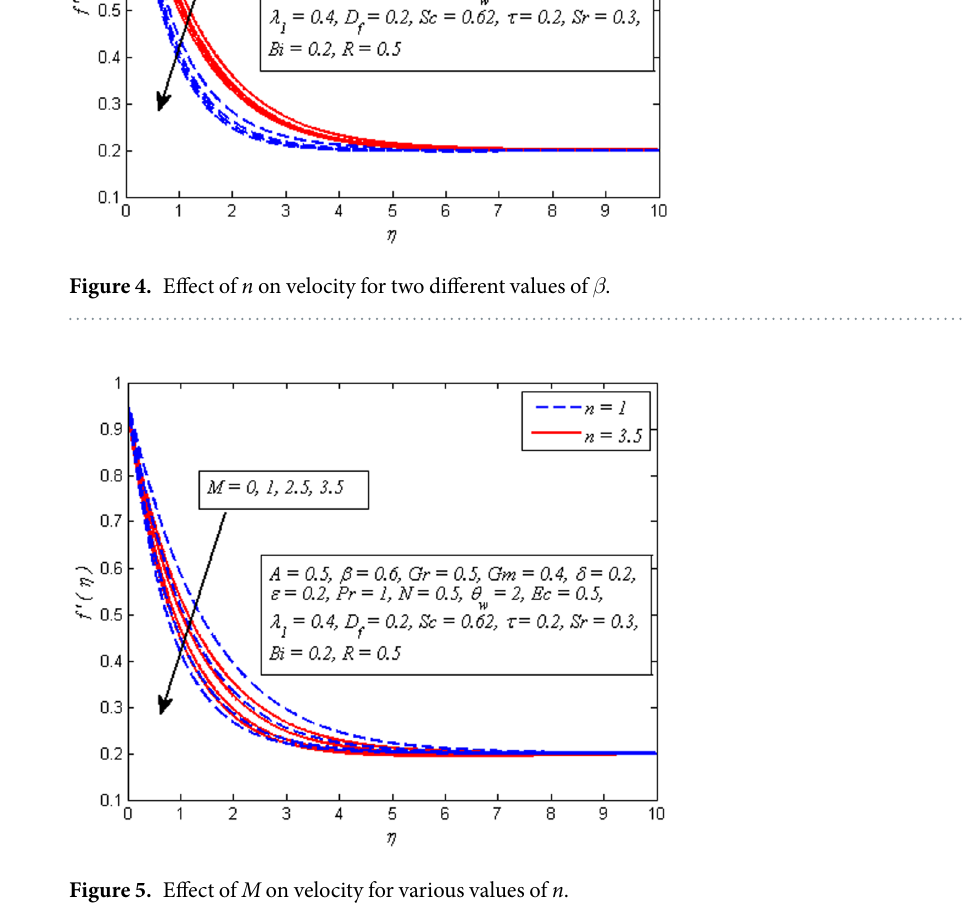
Figure 5. Effect of M on velocity for various values of n